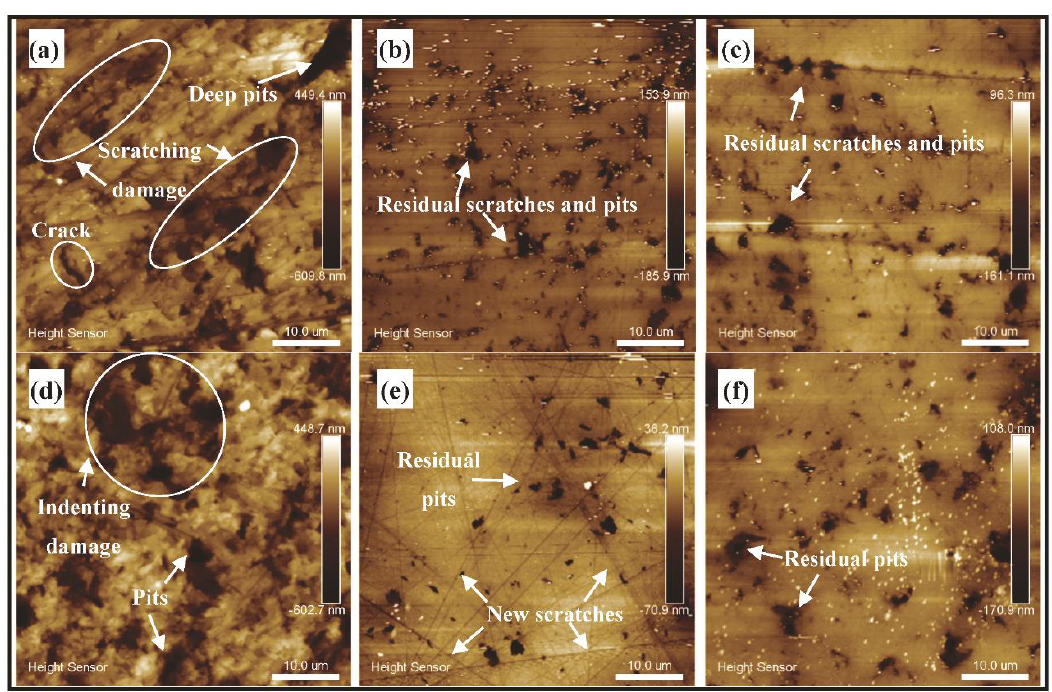
Figure 6. The variation of Si-face SiC surface morphology processed by different ways through atomic force microscopy (AFM) measurement (50 × 50 µ m 2 area): ( a ) conventional lapping; ( b ) conventional CMP after conventional lapping(C-c); ( c ) ultrasonic CMP after conventional lapping (C-u); ( d ) ultrasonic lapping; ( e ) conventional CMP after ultrasonic lapping (U-c); ( f ) ultrasonic CMP after ultrasonic lapping